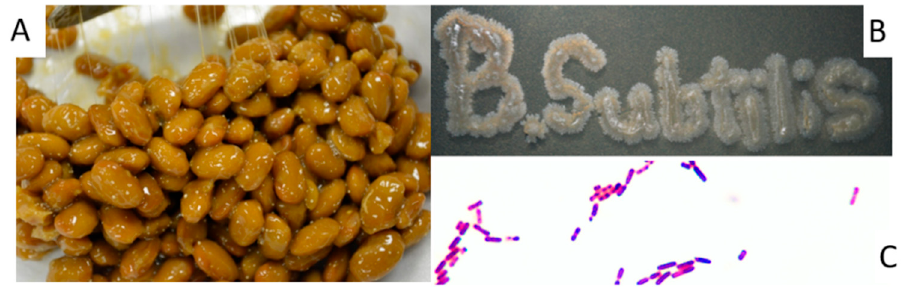
Figure 1. Natto—a traditional Japanese food produced from soybeans fermented by Bacillus subtilis (natto). ( A ) Natto-Fermented Soy Beans; ( B ) B. subtilis (natto) isolated from natto; ( C ) Micrograph of gram stained cells of B. subtilis (natto) (1000 × ).